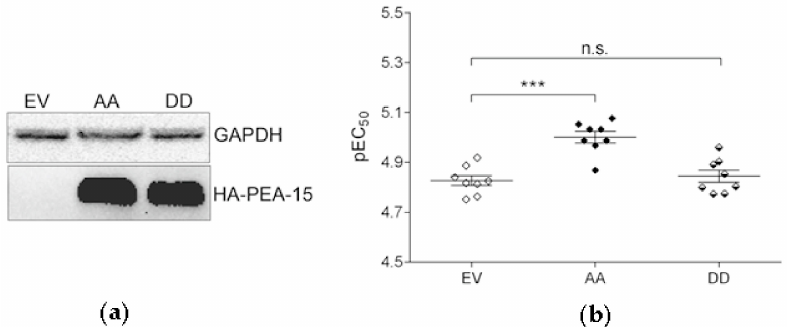
Figure 1. ( a ) Expression of hemagglutinin (HA)-tagged phosphoprotein enriched in astrocytes (PEA-15) in SKOV-3 cells after transfection with the HA-tagged empty vector (EV), PEA-15AA (AA) and PEA-15DD (DD). GAPDH was used as a loading control. ( b ) Cisplatin sensitivity (pEC 50 , mean ± SEM, n = 8) of transfected SKOV-3-EV (EV), SKOV-3-AA (AA) and SKOV-3-DD (DD) cells. *** p < 0.001, n.s. = not